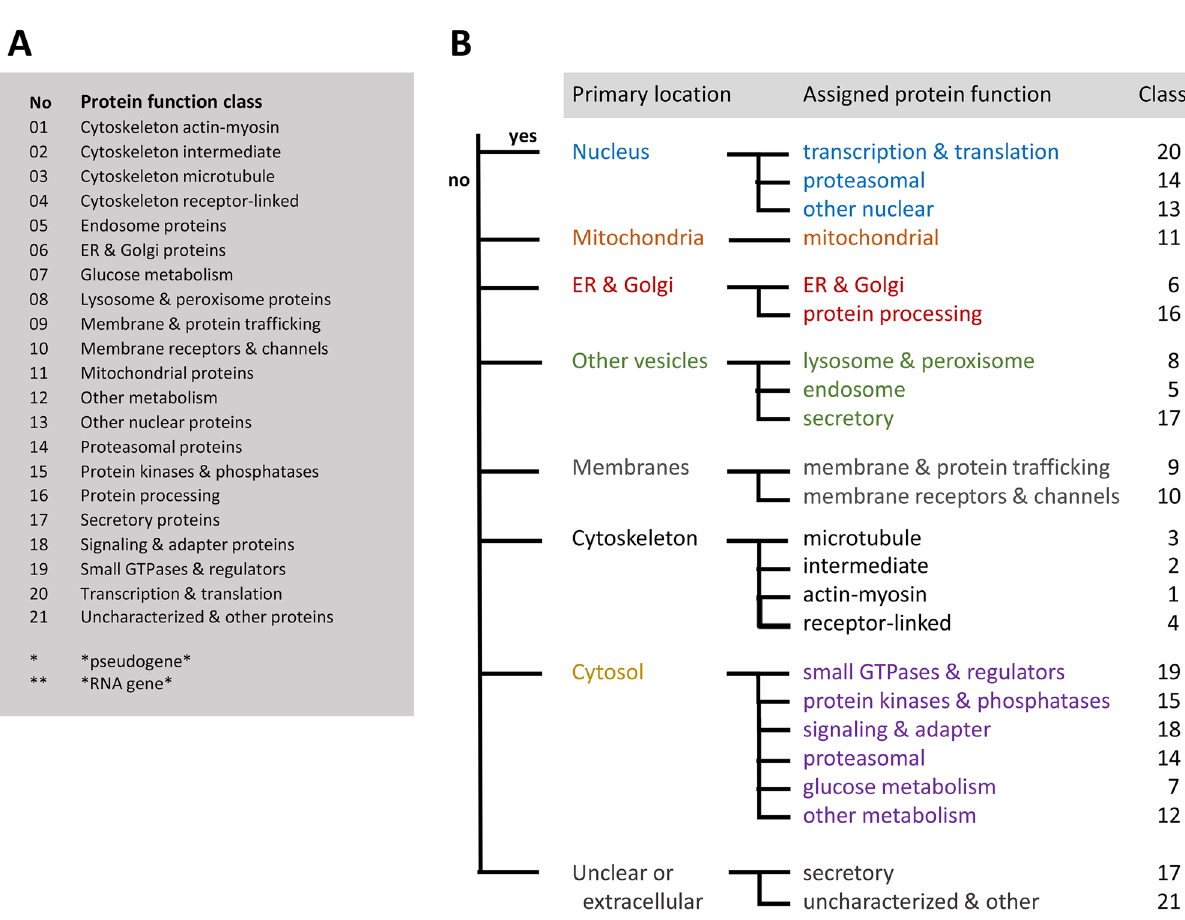
Figure 1. Classification scheme and decision tree for gene and protein assignment to 21 function classes. Assignment was based on primary subcellular localization of the protein and its assumed function according to UniProt-KB. ( A ) Class numbering in alphabetical order. ( B ) Hierarchical decision